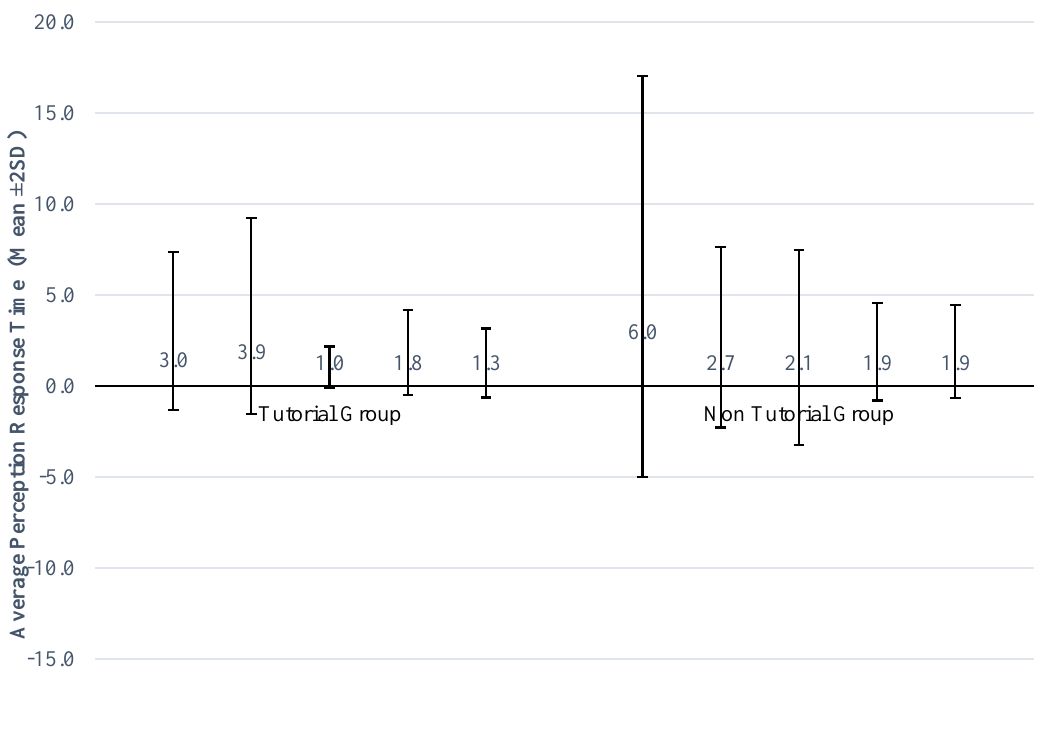
Figure 4. Standard deviation error bar of perception response time from each session vs. tutorial and non-tutorial groups.